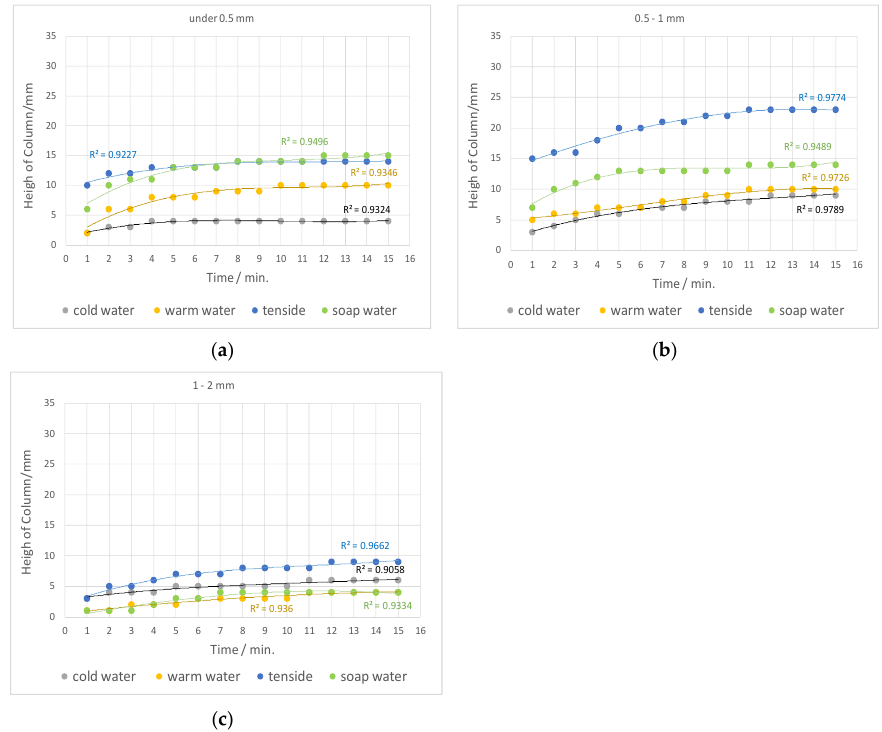
Figure 5. Wetting of biomass consisting of Lavandula angustifolia at granulometric compositions: ( a ) Under 0.5 mm; ( b ) 0.5–1 mm; ( c ) 1–2 mm. Appl. Sci. 2020 , 10 , x